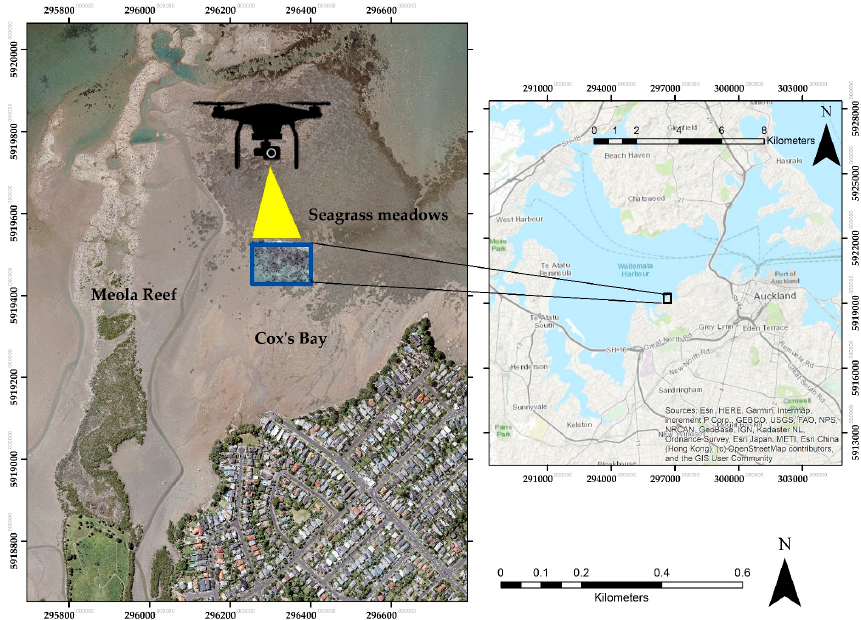
Figure 1. Location of the study site, North Island of New Zealand. Seagrass meadows are spatially located adjacent to the Meola intertidal reef, where wild oyster reefs and mangroves dominate. Base imagery source: Land Information New Zealand (LINZ), 2019 [39].